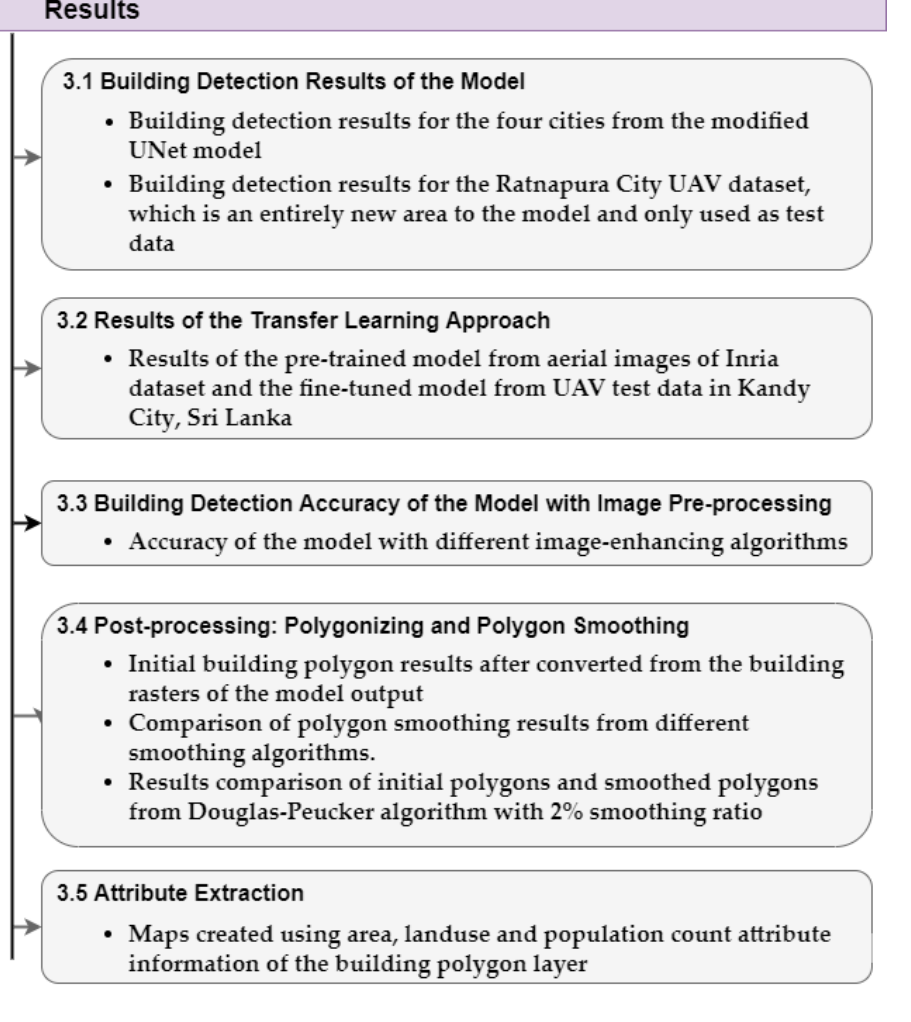
Figure 7. Results ’ chapter overview. Figure 7. Results’ chapter